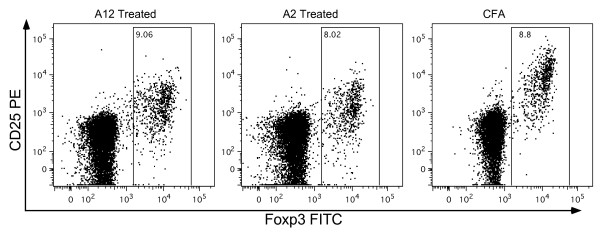
A12-responsive T cells are not Tregs. Inguinal lymph node cells from DR1 Tg mice immunized 10 days earlier with A12/CFA (left panel), A2/CFA (middle panel), or Ova/CFA (right panel) were cultured directly ex vivo with anti CD25, CD4+, VB8+, VB14+, and intracellular FoxP3. Selective gating was performed on the CD4+, VB8+VB14+ cells. Before intracellular staining, a sample of the A12-specific cells was stained with DR1-A12 tetramer to confirm that the VB8+, VB14+ population was enriched for tetramer+ cells (15% tetramer+). The experiments were repeated after 4 days of culture with the A12 peptide in vitro, and the results were similar to those shown. These data indicate that the numbers of Foxp3+, CD25+ Treg cells remain at background levels after immunization with A12/CFA.